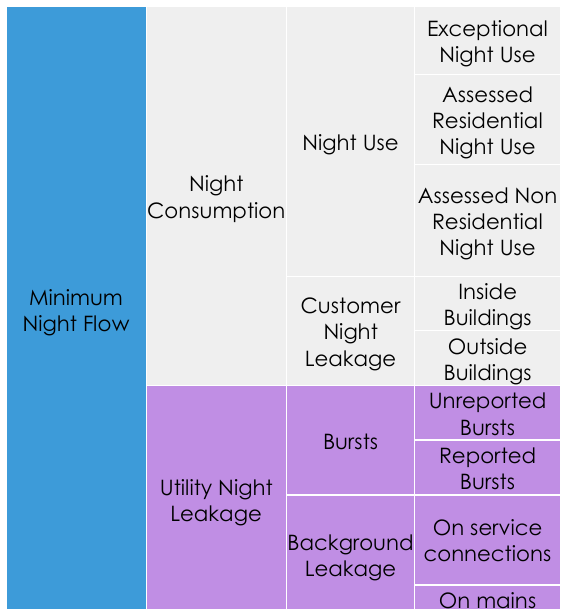
Figure 8. Components of Minimum Night Flow, source: WLSG Night Flow Team (2010) [4].